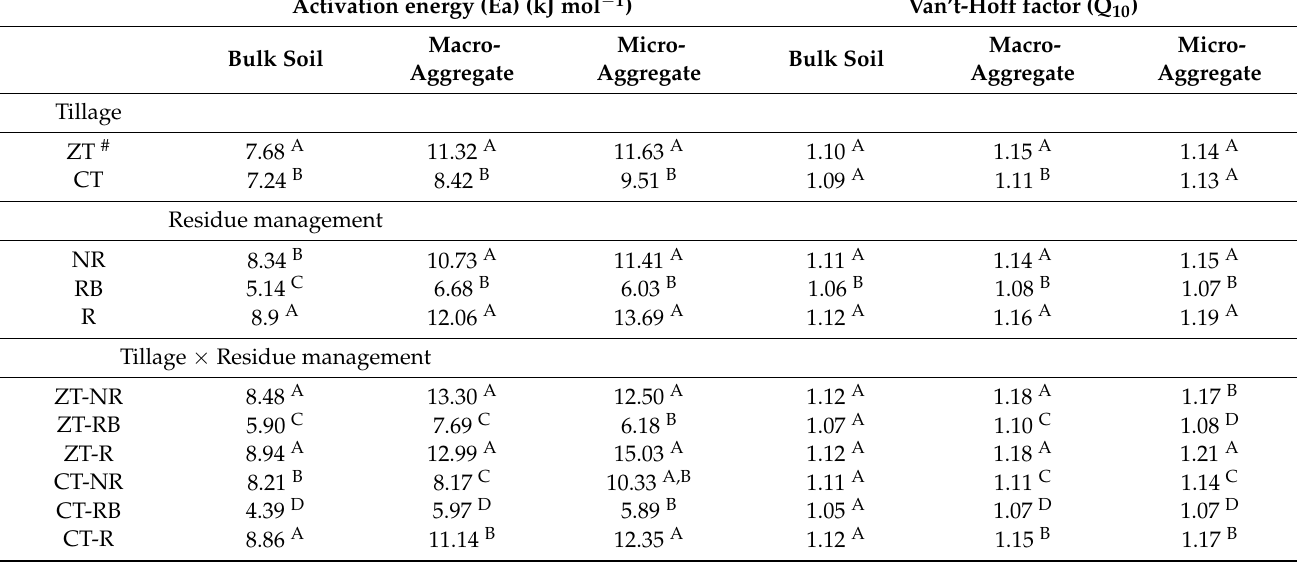
Table 2. Activation energy (Ea) and Van’t-Hoff factor (Q 10 ) of SOC mineralization in bulk and aggregate soils of 0–5 cm as influenced by 18 years of tillage and residue management under a rice–wheat cropping system in an